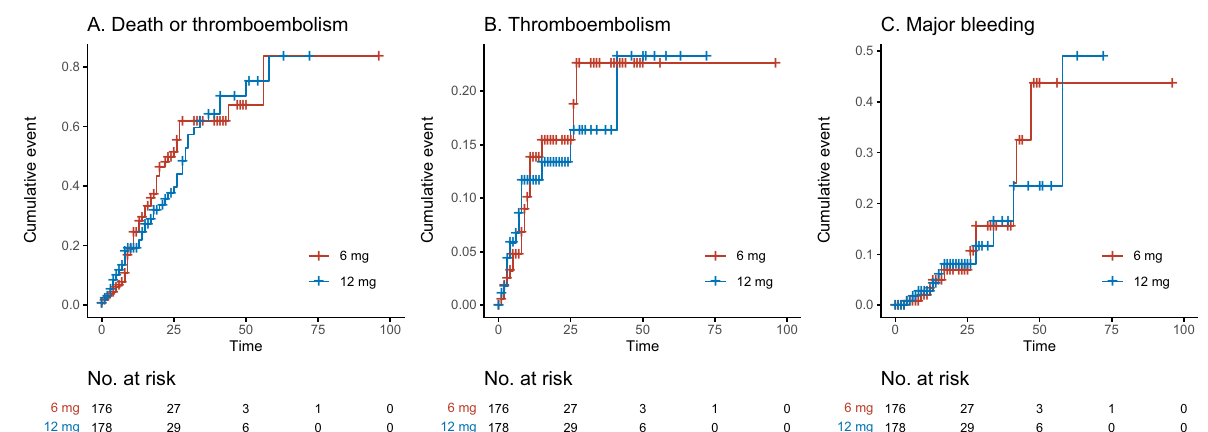
Fig. 2 Kaplan–Meier curves of outcomes during ICU stay according to dose of dexamethasone. Kaplan–Meier curves of A Death or Thromboembolism B Thromboembolism, and C Major bleeding events among 354 patients with critical COVID‑19 by dose of dexamethasone. Thromboembolism in A and B defined as myocardial infarction, pulmonary embolism/thrombosis, deep vein thrombosis, ischemic stroke or other thromboembolic events. Major bleeding in C defined as a bleeding requiring transfusion of at least two units of red blood cells, an intracranial bleeding, and or a bleeding requiring a major therapeutic intervention